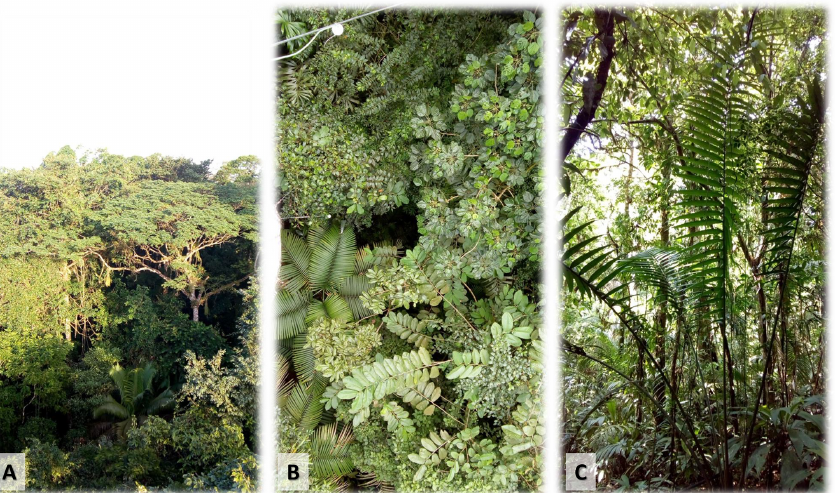
Figure A1. Images of the three canopy layers defined in this study. A is the lateral view of the overstory layer ( ∼ 10–43m) within the canopy gap. B is the vertical view of the upper understory layer (between 8 to 10m). C is the lateral view of the lower understory (0–2m).